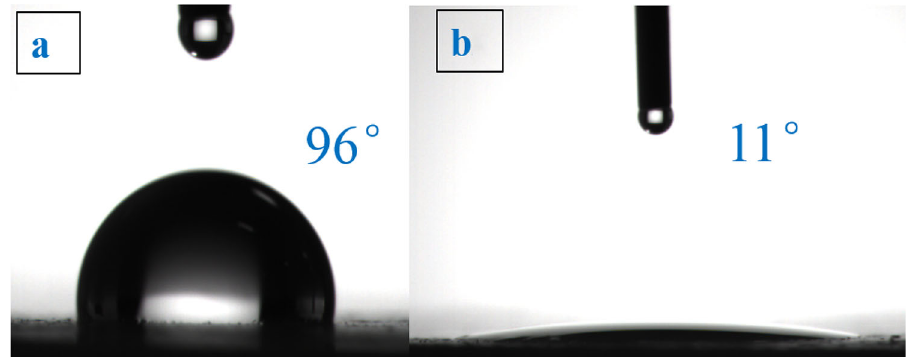
Fig. 3 Contact angle of coal ( a ) and kaolinite ( b